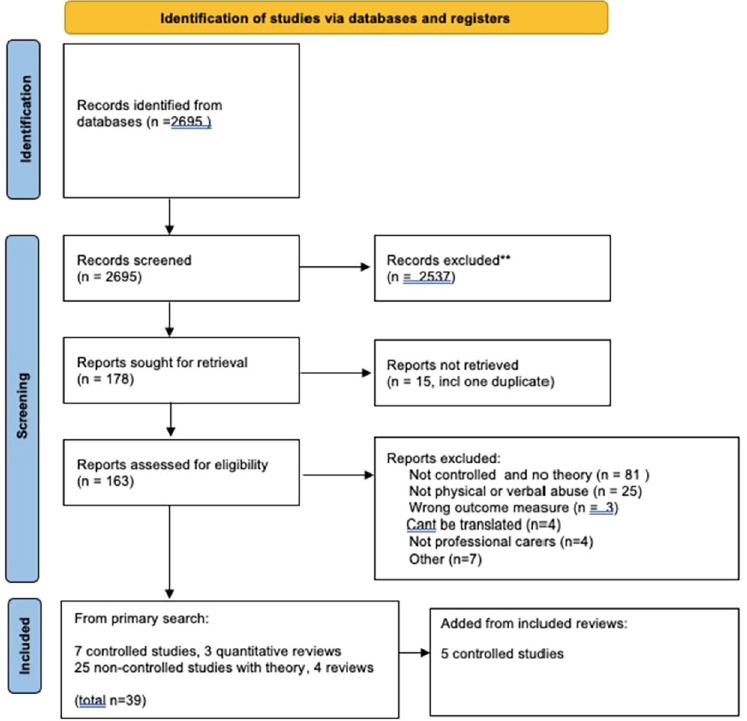
Fig 2. PRISMA flow chart, updated search (22 nd March 2022). From : Page MJ, McKenzie JE, Bossuyt PM, Boutron I, Hoffmann TC, Mulrow CD, et al. The PRISMA 2020 statement: an updated guideline for reporting systematic reviews. BMJ 2021;372:n71. doi: 10.1136/bmj.n71.